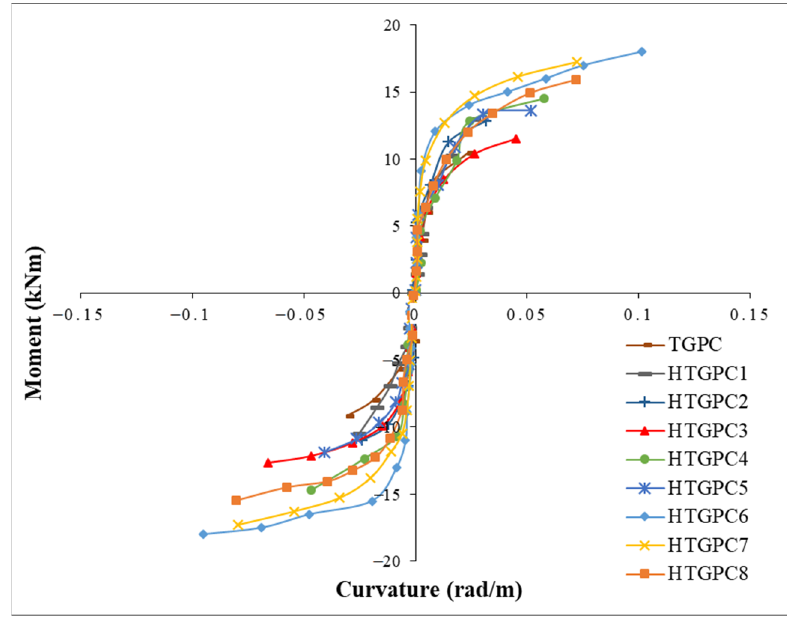
Figure 7. Moment–curvature envelope